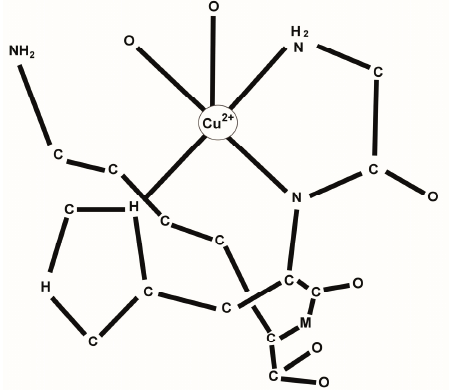
Figure 1. Molecular structure of the tri-peptide